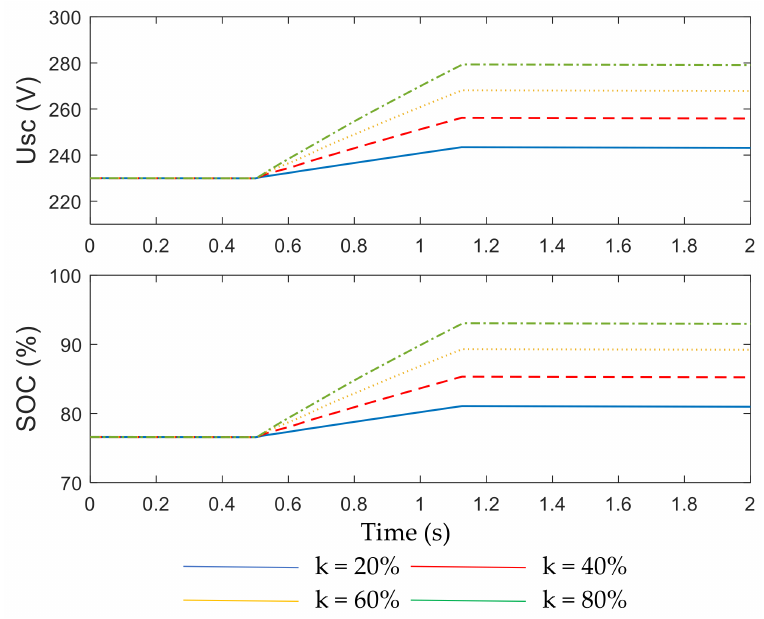
Figure 12. The simulation results of the supercapacitor energy storage (SCES) control